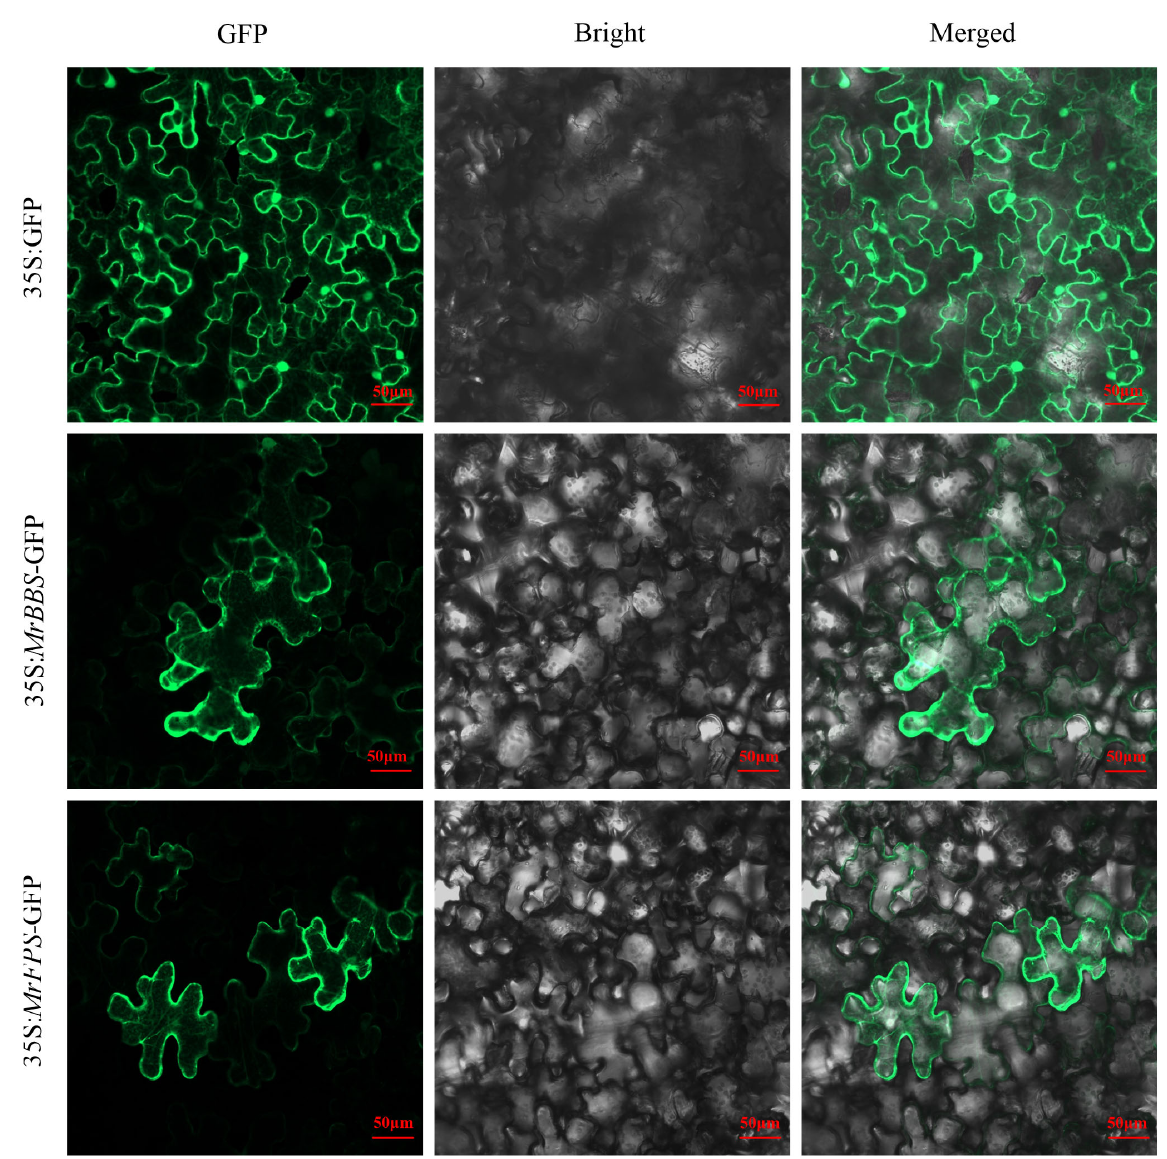
Figure 4. Subcellular localization of MrFPS and MrBBS in tobacco. All samples were visualized using confocal microscopy. GFP means GFP fluorescence; Bright means Light field; Merged means superposition of fluorescence. Control vector (35S: GFP) and recombinant vectors (35S: MrFPS ‐ GFP and 35S: MrBBS ‐ GFP) were expressed in protoplasts of tobacco.